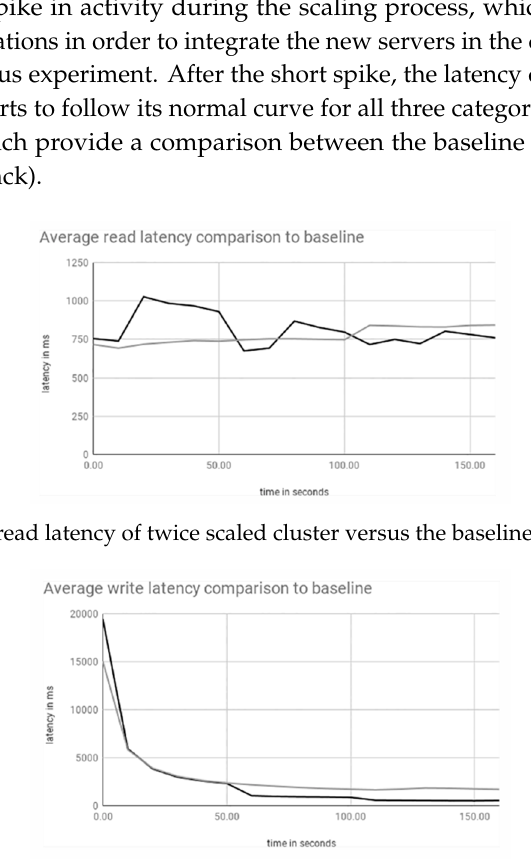
Figure 21. Average command latency of scaled cluster versus the baseline, single shard cluster.